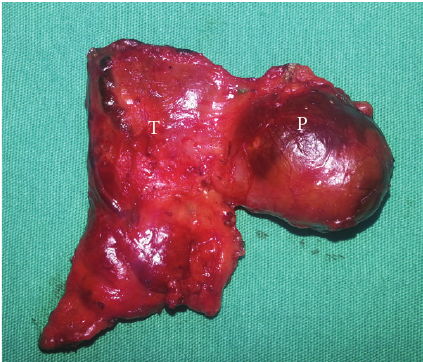
Figure 4: Macroscopic image of left thyroid lobe and parathyroid